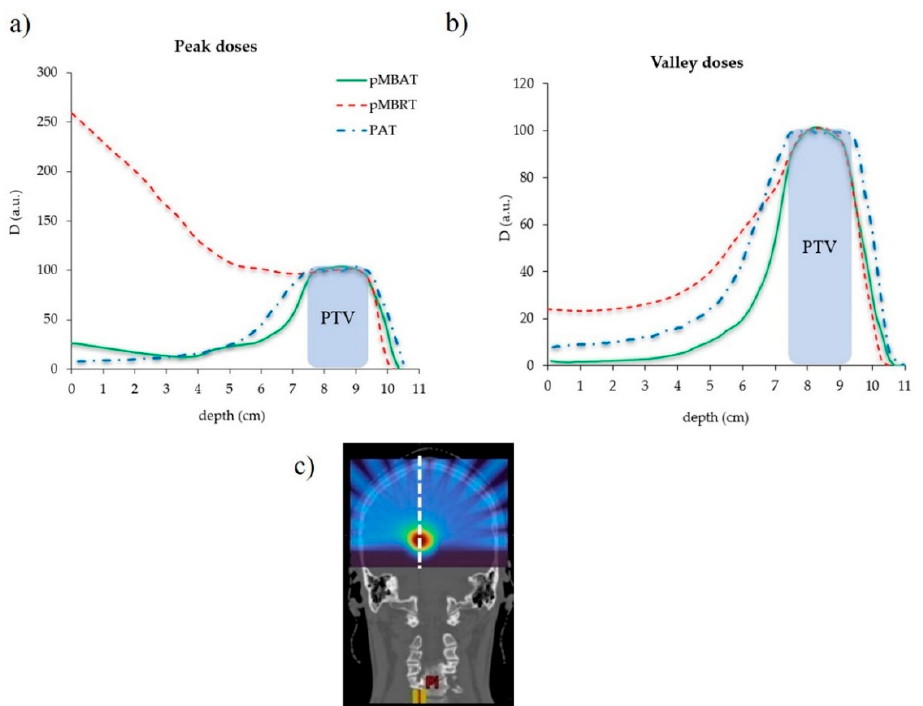
Figure 4. Depth dose profiles at ( a ) peak and ( b ) valleys positions of the standard pMBRT (single array), PAT and pMBAT (multi-array) scenarios. The profile considered is represented by a dotted white line in ( c ). Doses are normalized to the maximum dose at peak and valleys, respectively.